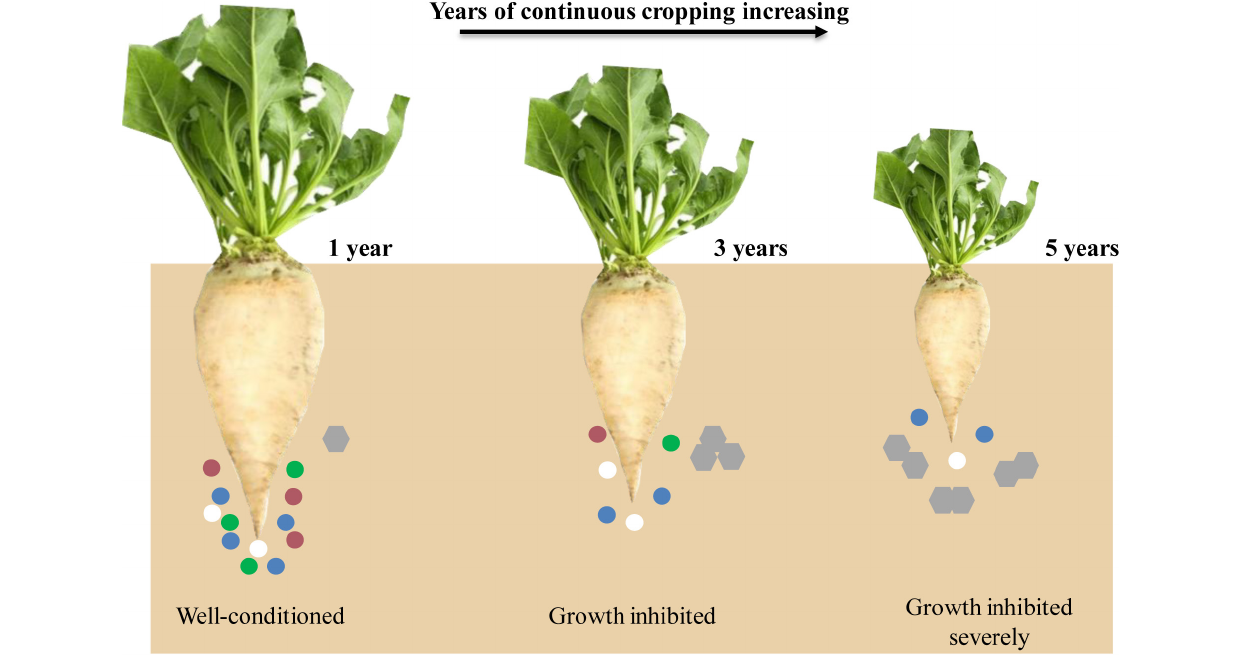
actual mass tolerance, 5 ppm; signal intensity tolerance,